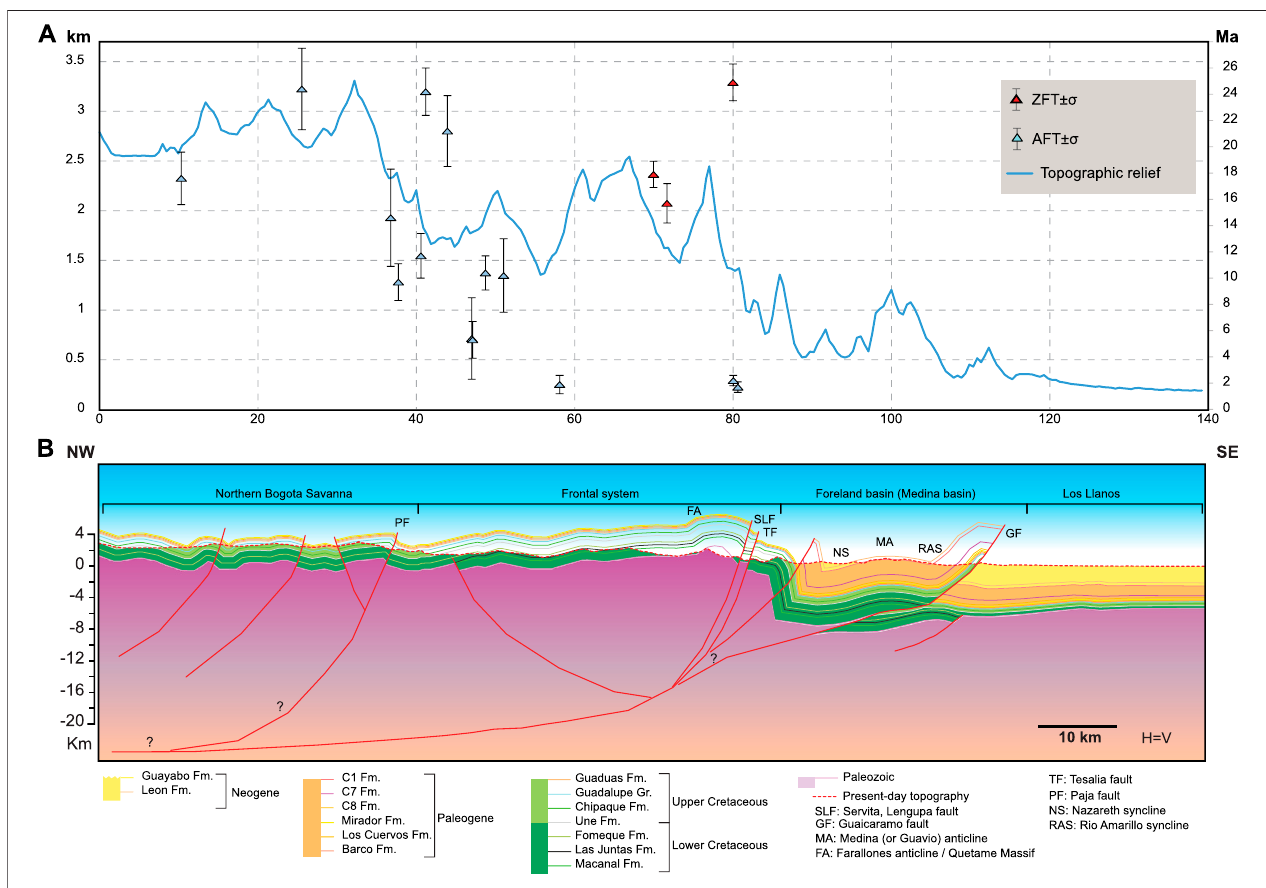
FIGURE 9| (A) Distribution of the thermochronometric data along Section 10. (B) 2D section construction and balancing of Sections 10 (see location in Figure 5 ).